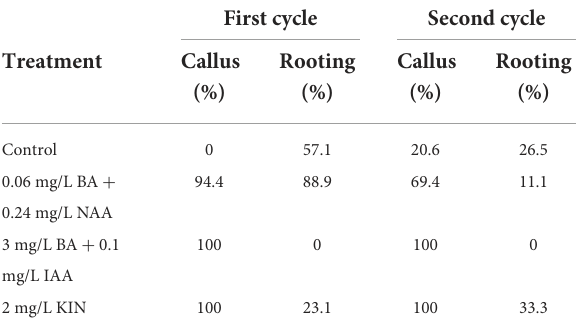
TABLE 2 Percentage of callus formation and rooting of sea knotgrass explants subjected to two consecutive cycles of in vitro shoot multiplication cultivated in MS medium alone (control) and with different growth regulators (BA + NAA; BA + IAA and KIN) after 60 days.